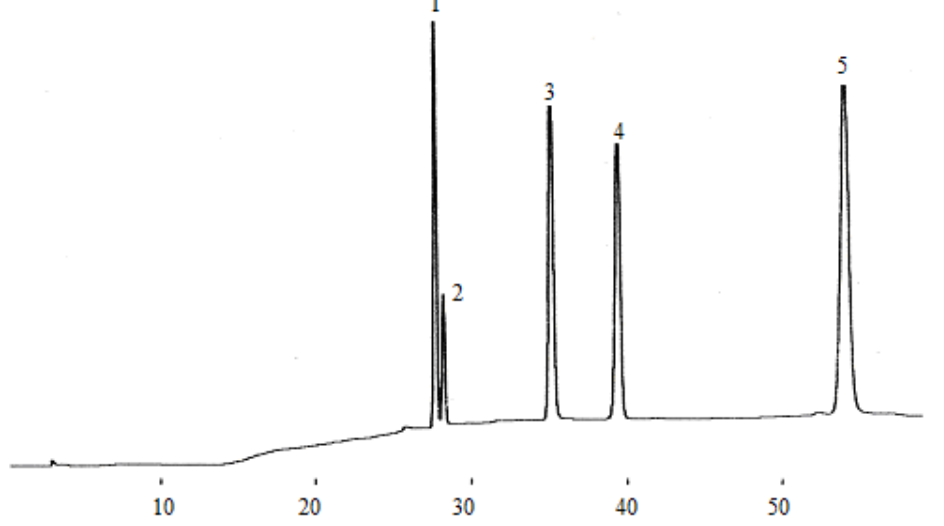
Figure 4. Flavan-3-ol compounds detected in the dry wine samples. (1) catechin,